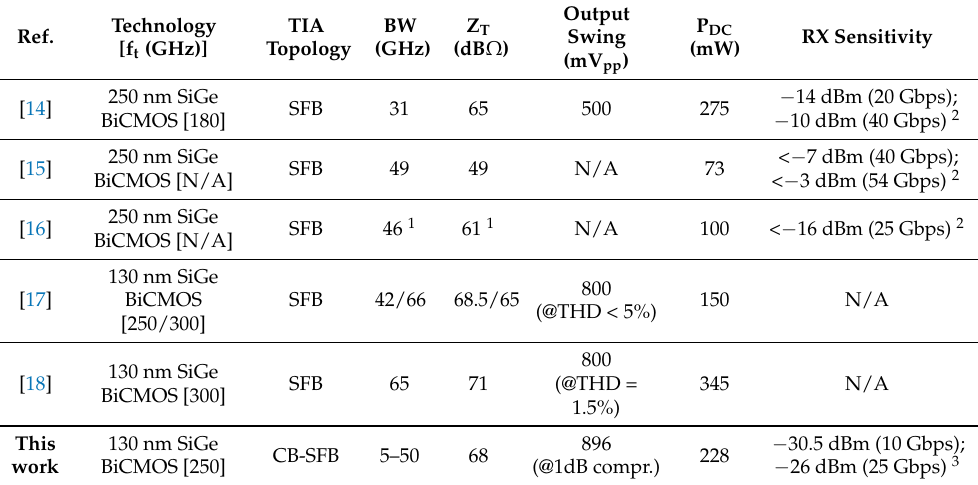
Table 1. Comparison of the proposed TIA against the state-of-the-art.